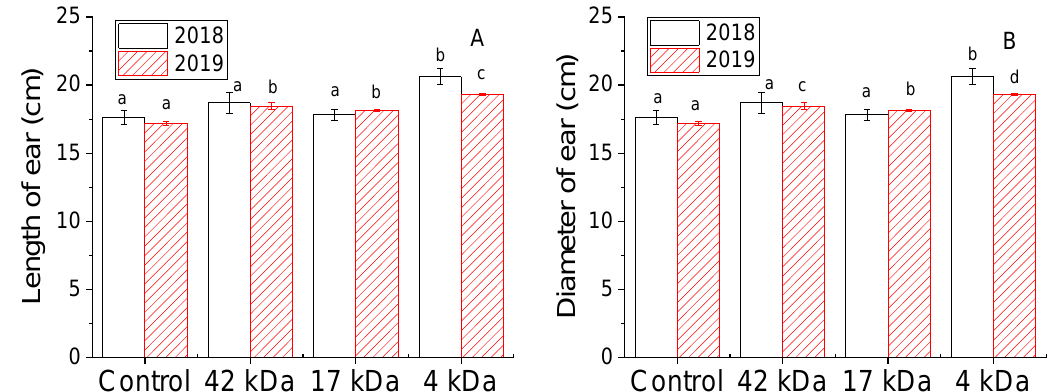
Figure 4. Influence of MWs on length of ear ( A ) and diameter of ear ( B ) collected in 2018 and 2019. Bars represent mean values of three replicates ± standard deviation. Different letters indicate significant differences ( p < 0.05).